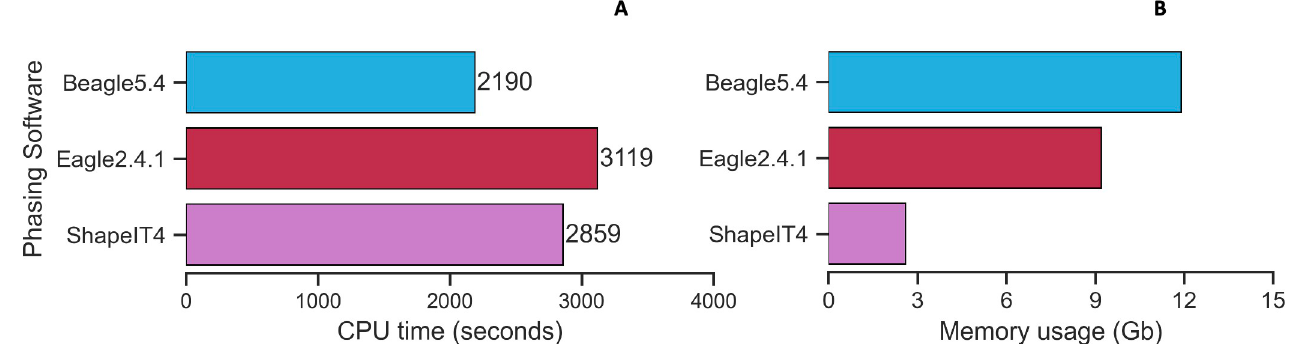
Fig 5. CPU run time and memory usage of phasing software in trios dataset. Average run time for phasing (5A). Average memory usage for phasing (5B) in trios data.